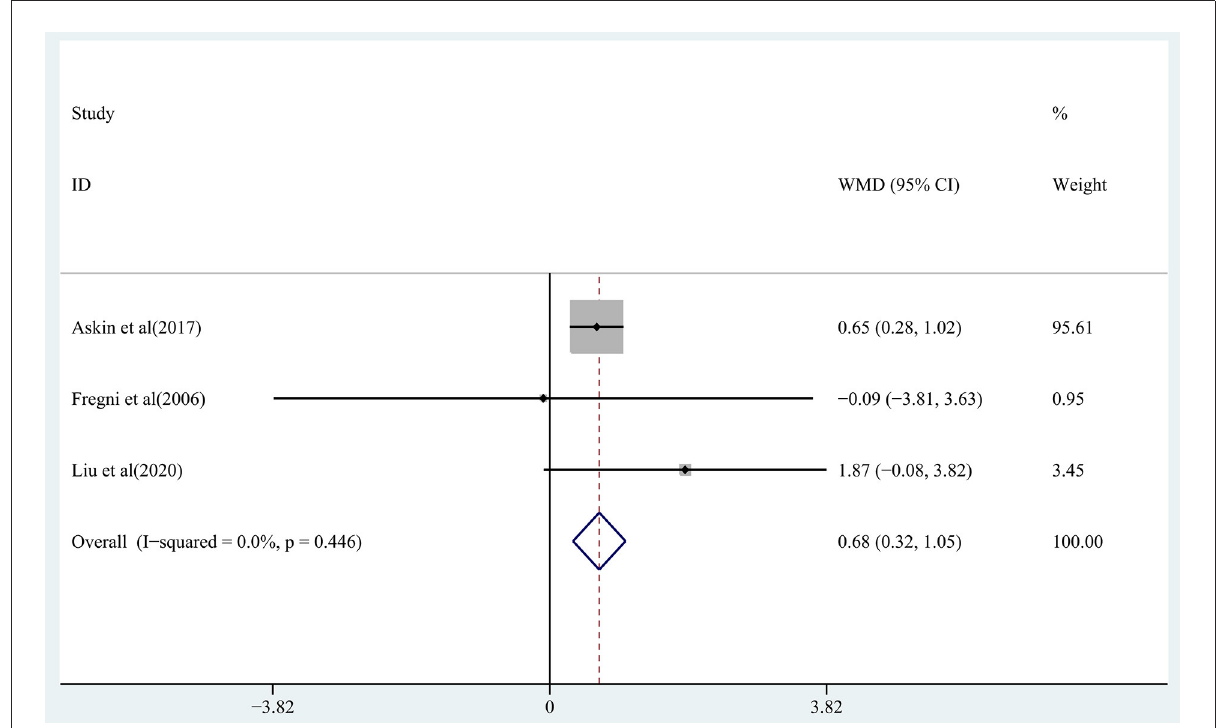
FIGURE6 Forest plot of the effect of rTMS treatment on cognitive function recovery in chronic stroke